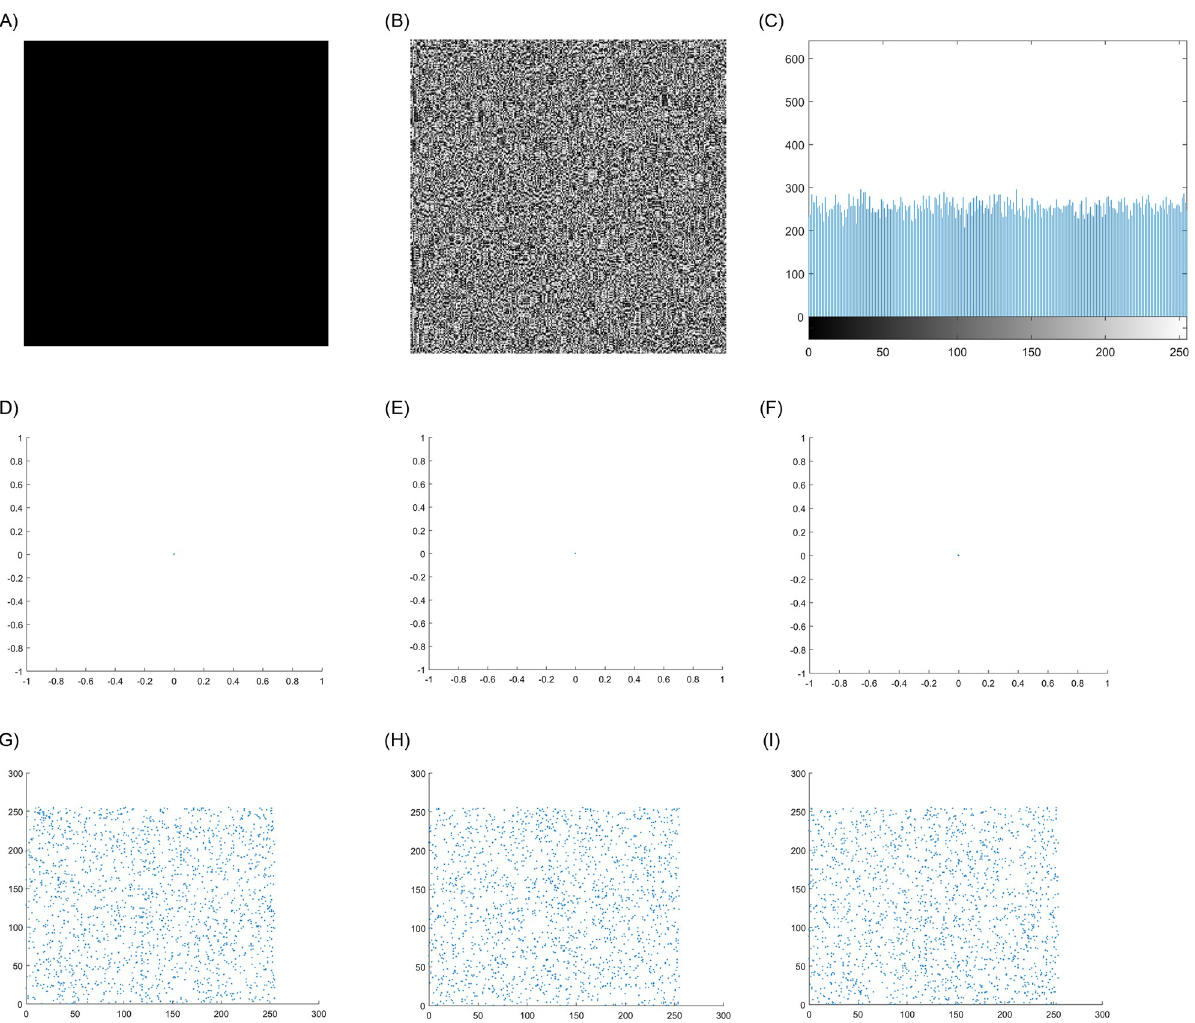
Fig 11. Analysis of encryption test results of all black images. A: Original full black image. B: Encrypted full black image. C: Histogram of encrypted image. D: Horizontal pixel of original image. E: Vertical pixel of original image. F: Diagonal pixel of original image. G: Horizontal pixel of encrypted image. H: Vertical pixel of encrypted image. I: Diagonal pixel of encrypted image.